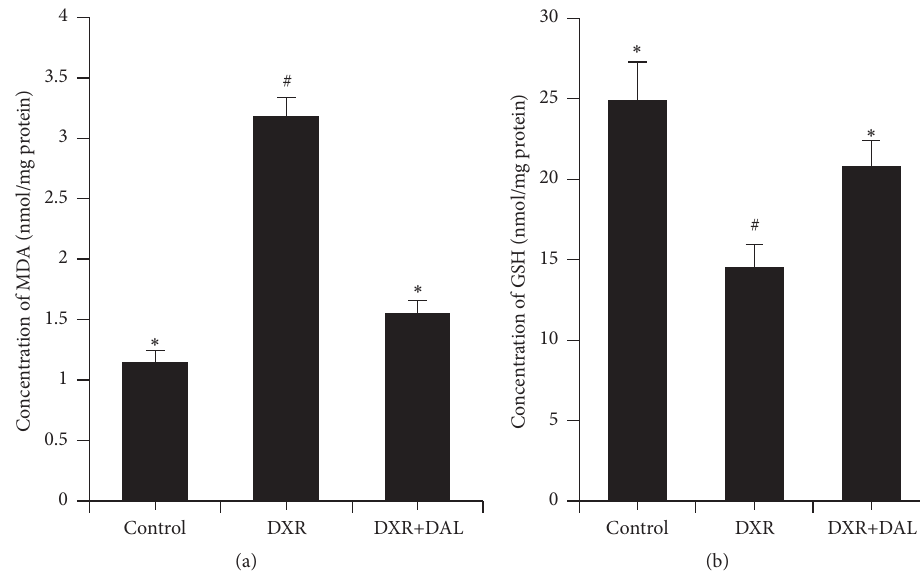
Figure 3: Redox microenvironment in kidney tissue at 5 weeks after DXR injection in different groups of mice as indicated. (a) Effect of DAL on kidney MDA levels; (b) Effect of DAL on kidney GSH levels. The control and DAL treatment groups are compared with the DXR group. Values are statistically significant at ∗ 𝑝 < 0.05 ; the DXR group is compared with the control group. Values are statistically significant at # 𝑝 < 0.05